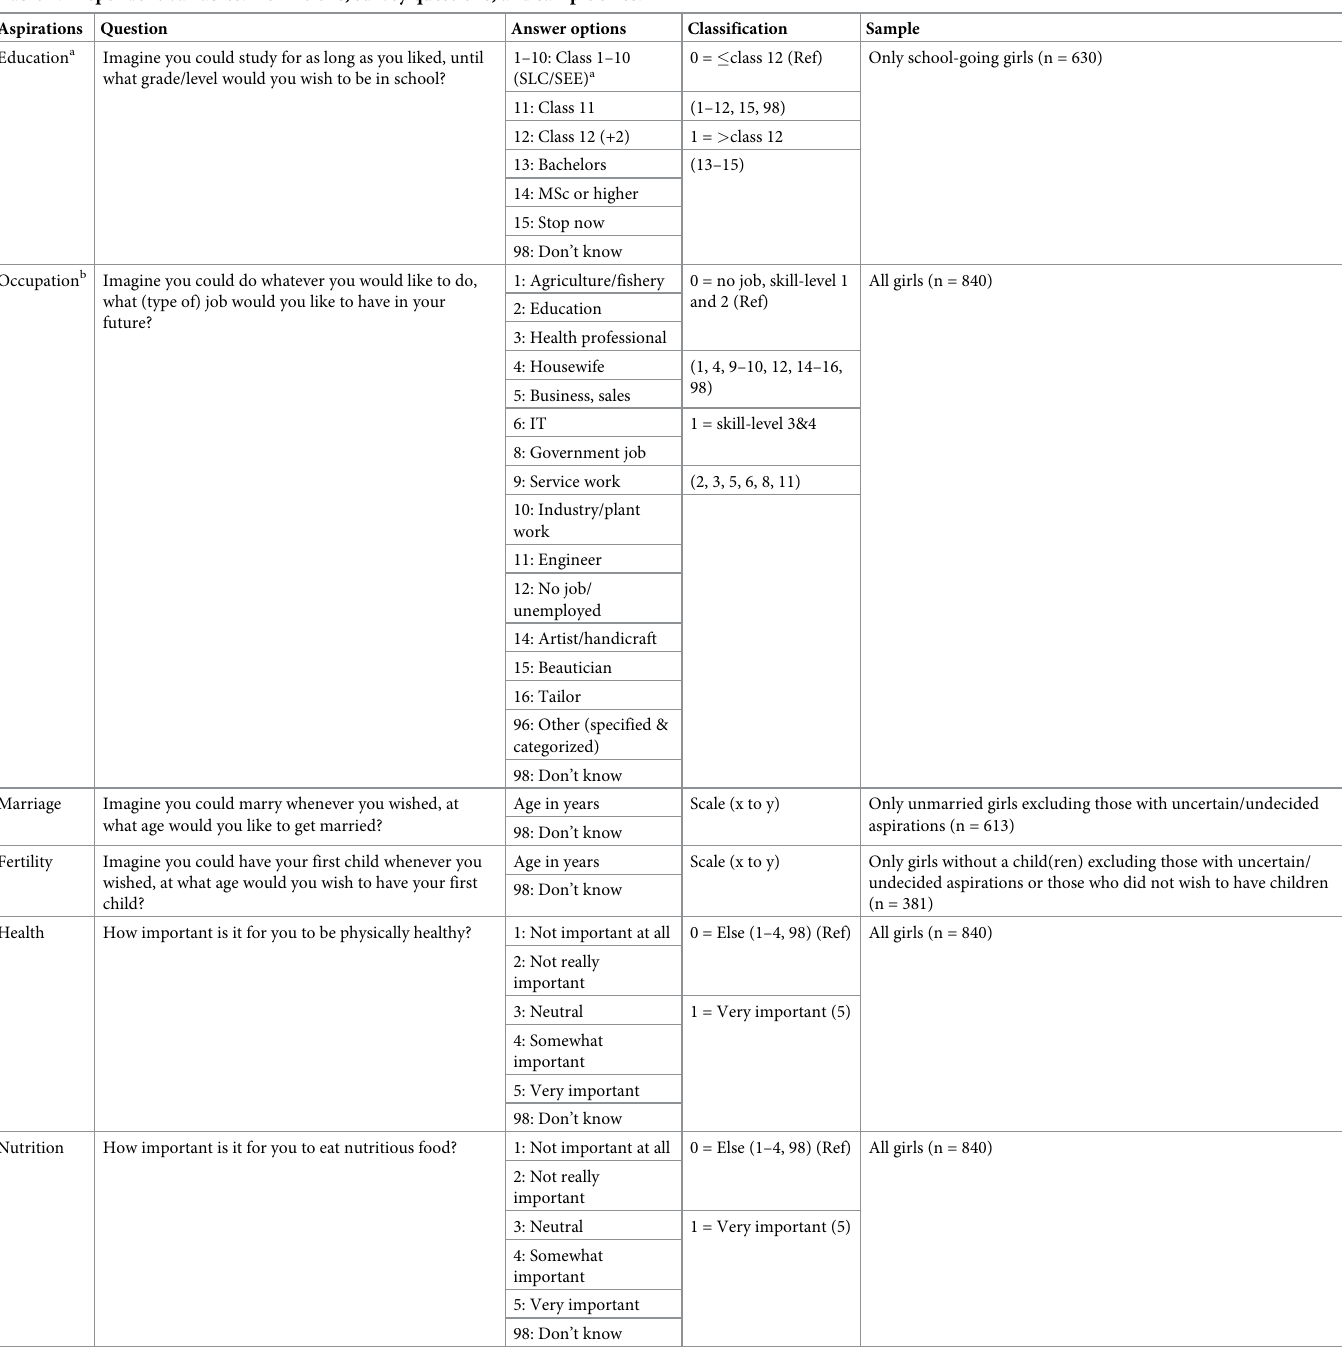
Table 1. Dependent variables: Definitions, survey questions, and sample